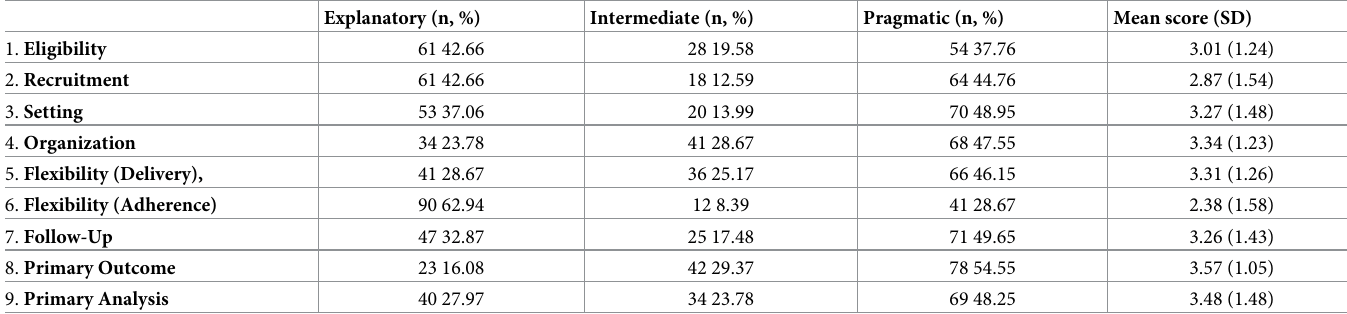
Table 2. Number of studies with an explanatory, intermediate and pragmatic domain. Mean scores and standard deviations for each domain of the PRECIS-2 tool.